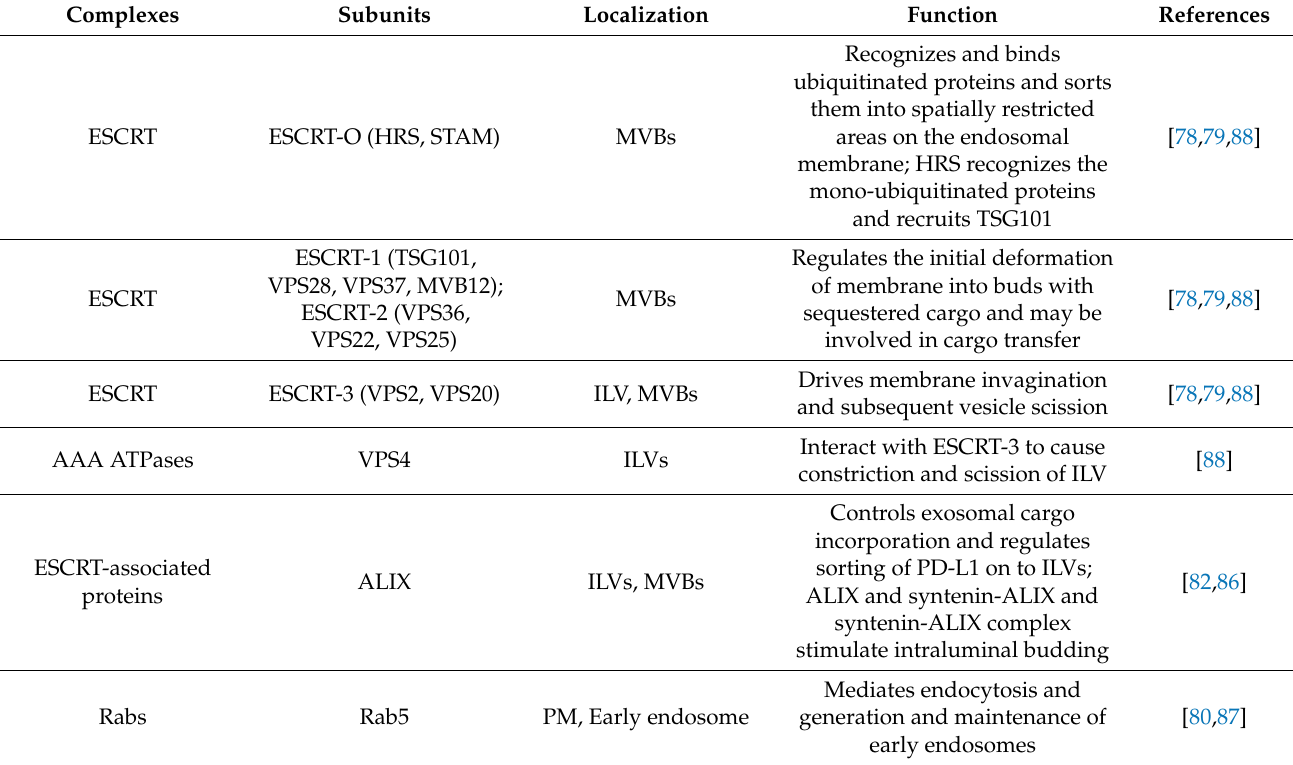
Table 1. Composition and function of complexes and key enzymes related to exosome biogenesis, sorting, transport, and